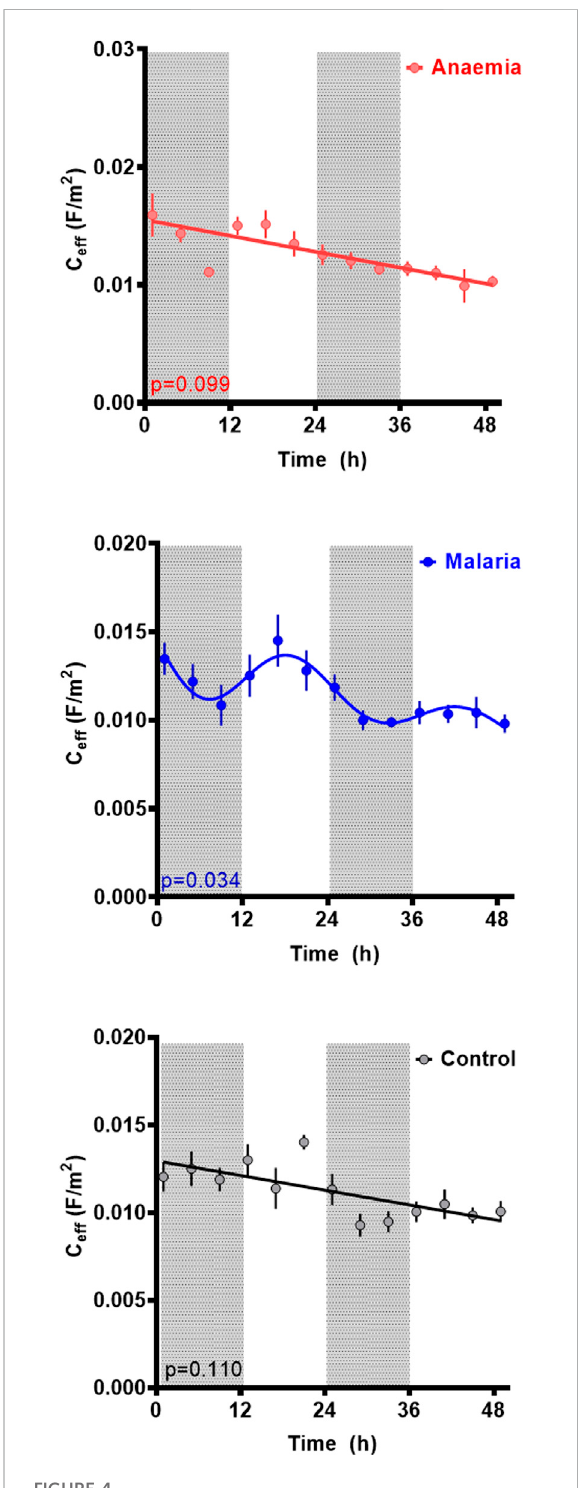
FIGURE 4 Membrane capacitance (C eff ) per unit area for RBCs from untreated controls (black), malaria-infected (blue) and anemic mice (red). Mean ± SEM and best fi tting models for C eff as a function of time since the experiment began, with ZT